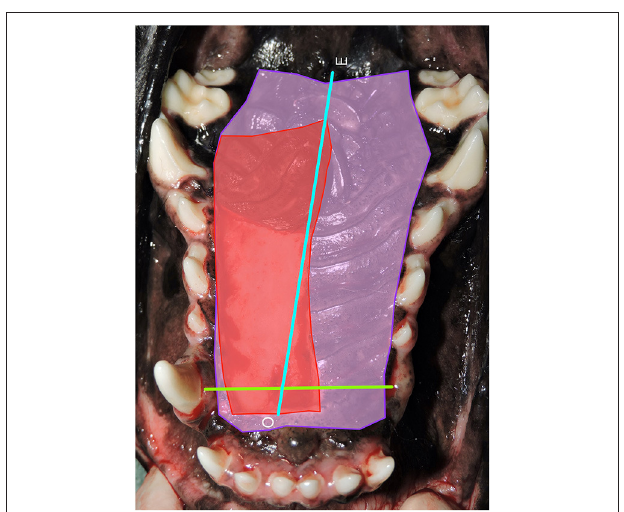
FIGURE 2 | Step 1: Hard palate measurements. Photograph of the area of the hard palate with all measurements used for analysis. Purple shaded area: estimated total hard palate mucoperiosteal flap (HPF) area (pixels 2 ) utilized in the repair. Red shaded area: standard unit for each patient that could be used to evaluate the significance of the distance traveled by the apex of the hard palate mucoperiosteal flap. Green line: The distance between the base of the canine teeth on the palatal surface was measured in pixels for each patient and used as normalized palatal length factor (Lp) in order to compare across species, breed, and relative patient size. Blue line: Determination of the relative distance traveled by the hard palate mucoperiosteal flap (HPF) by measuring from the original location of the apex of the HPF to the final location resulting in another pixel value. O, origin of flap apex; E, endpoint of flap